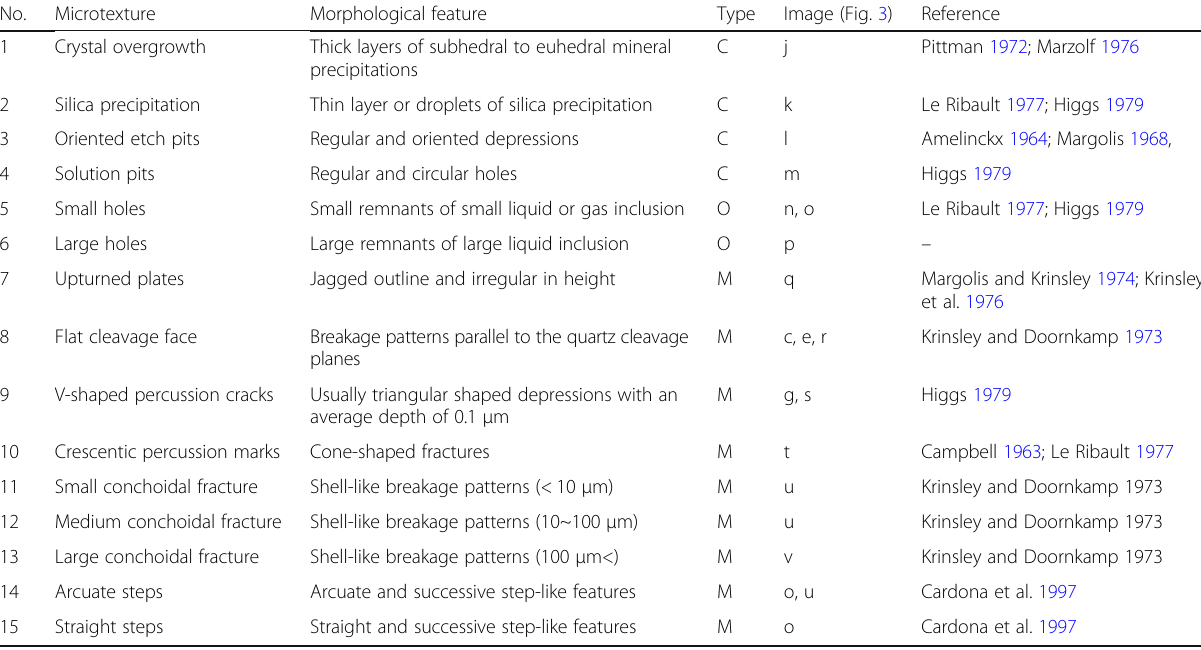
Table 1 Observed microtextures and their morphological features. C: chemical features, O: original features, M: mechanical features